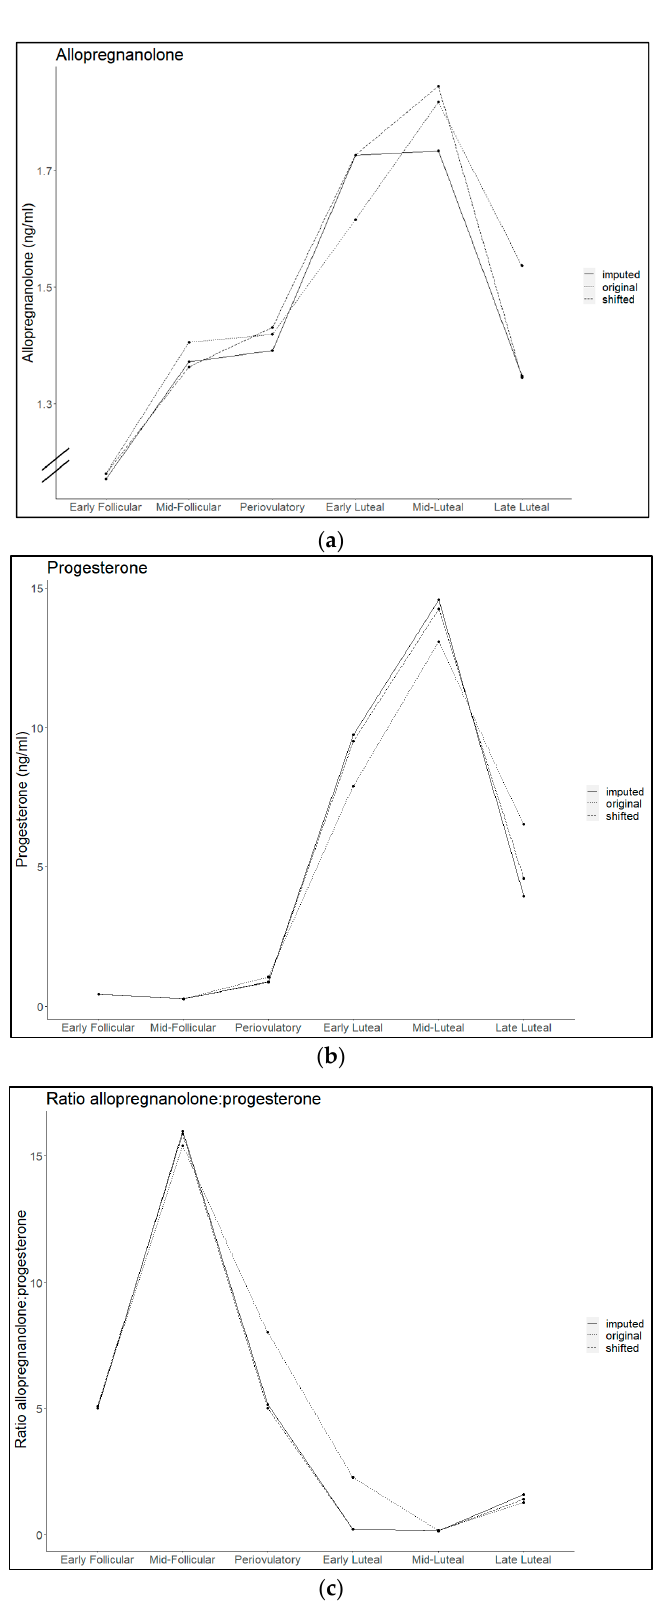
Figure 2. Allopregnanolone ( a ), progesterone ( b ), and allopregnanolone:progesterone ratio ( c ) mean and variance (SEM; presented as error bars) at each of the six subphases of the menstrual cycle.